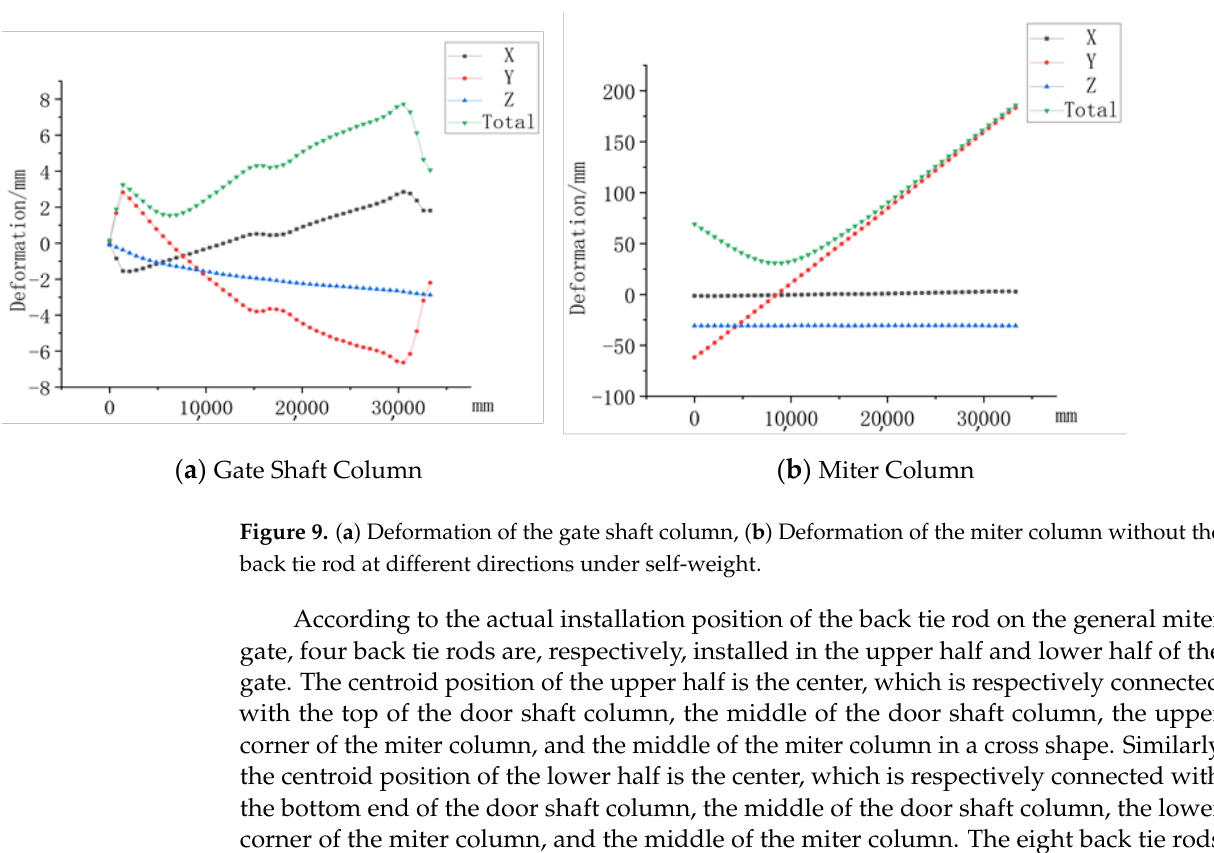
Figure 8. ( a ) Deformation of the overall gate, ( b ) Deformation of the gate shaft column, and ( c ) Deformation of the miter column without the back tie rod under self-weight.